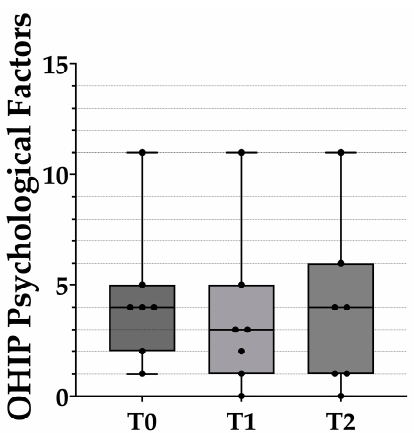
Figure 5. Box plots of the psychological impact scores from the OHIP-EDENT-J questionnaire. The black dots represent the distribution of raw data. T0: before the clinical remount. T1: immediately after the clinical remount. T2: 1 week after the clinical remount. Statistical analysis was performed with the Wilcoxon sign-rank test. Predetermined level of significance: p < 0.05.